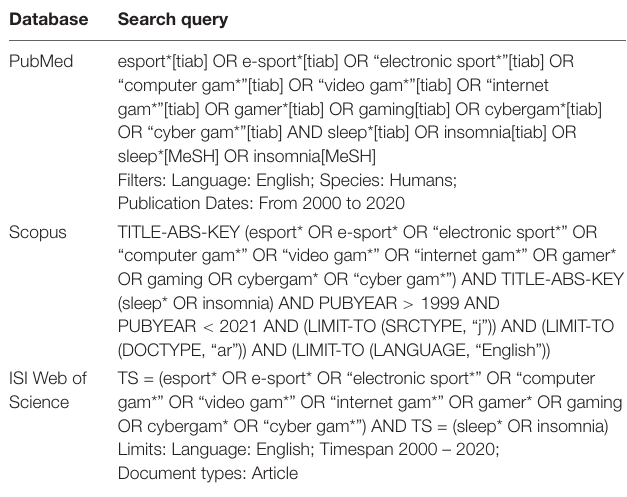
TABLE 1 | Systematic search strategy used in electronic